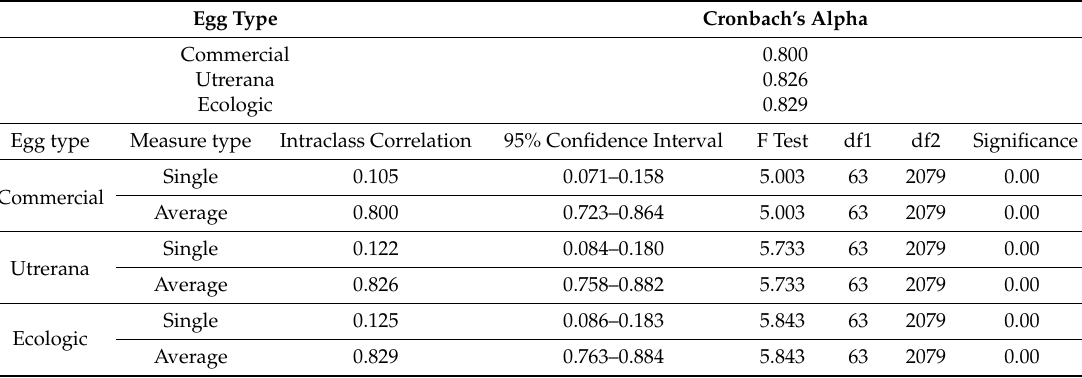
Table 1. Cronbach’s Alpha, Cohen’s kappa Intra Class Correlation Coe ffi cient and 95% confidence intervals for interobserver reliability testing and scale consistency sorted by egg